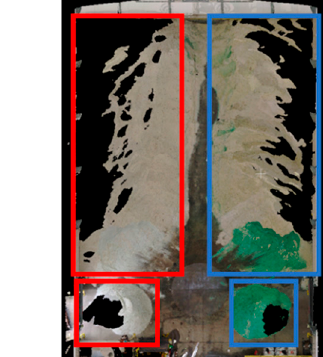
Figure 29. Salt repositioning experiment at the Lebanon facility.